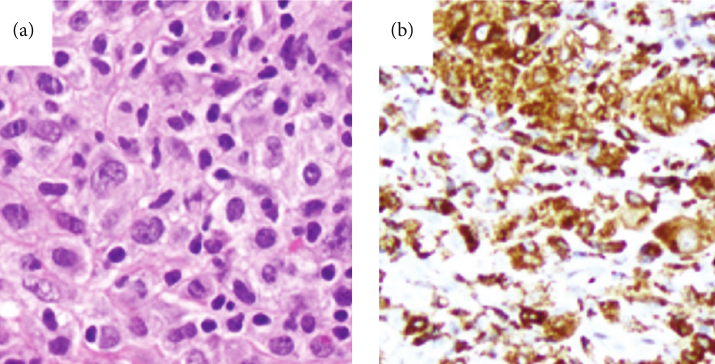
Figure 3: (a) Microphotograph of the histiocytic sarcoma cells. At high magnification, the neoplastic cells from the initial oropharynx biopsy are medium sized to large cells with irregular nuclear contours, delicate nuclear membrane, and abundant pale cytoplasm, consistent with atypical histiocytes (H&E, original magnification 400x). (b) Immunohistochemical features of the histiocytic sarcoma cells. The sarcoma cells are positive for CD68 (b, original magnification 200x), lysozyme (not shown), and CD45 (not shown). Approximately 10% of the sarcoma cells are positive for Ki-67 (not shown).